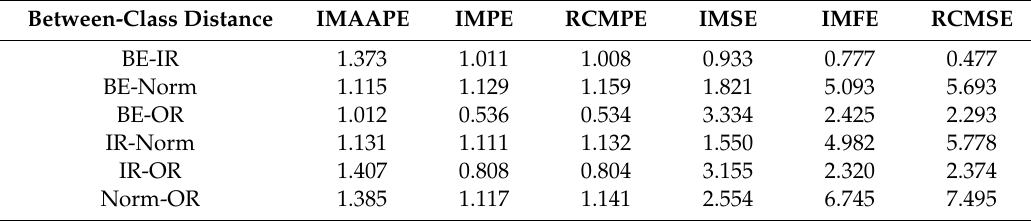
Table 3. The between-class distance of di ff erent rolling bearing fault feature extraction methods.